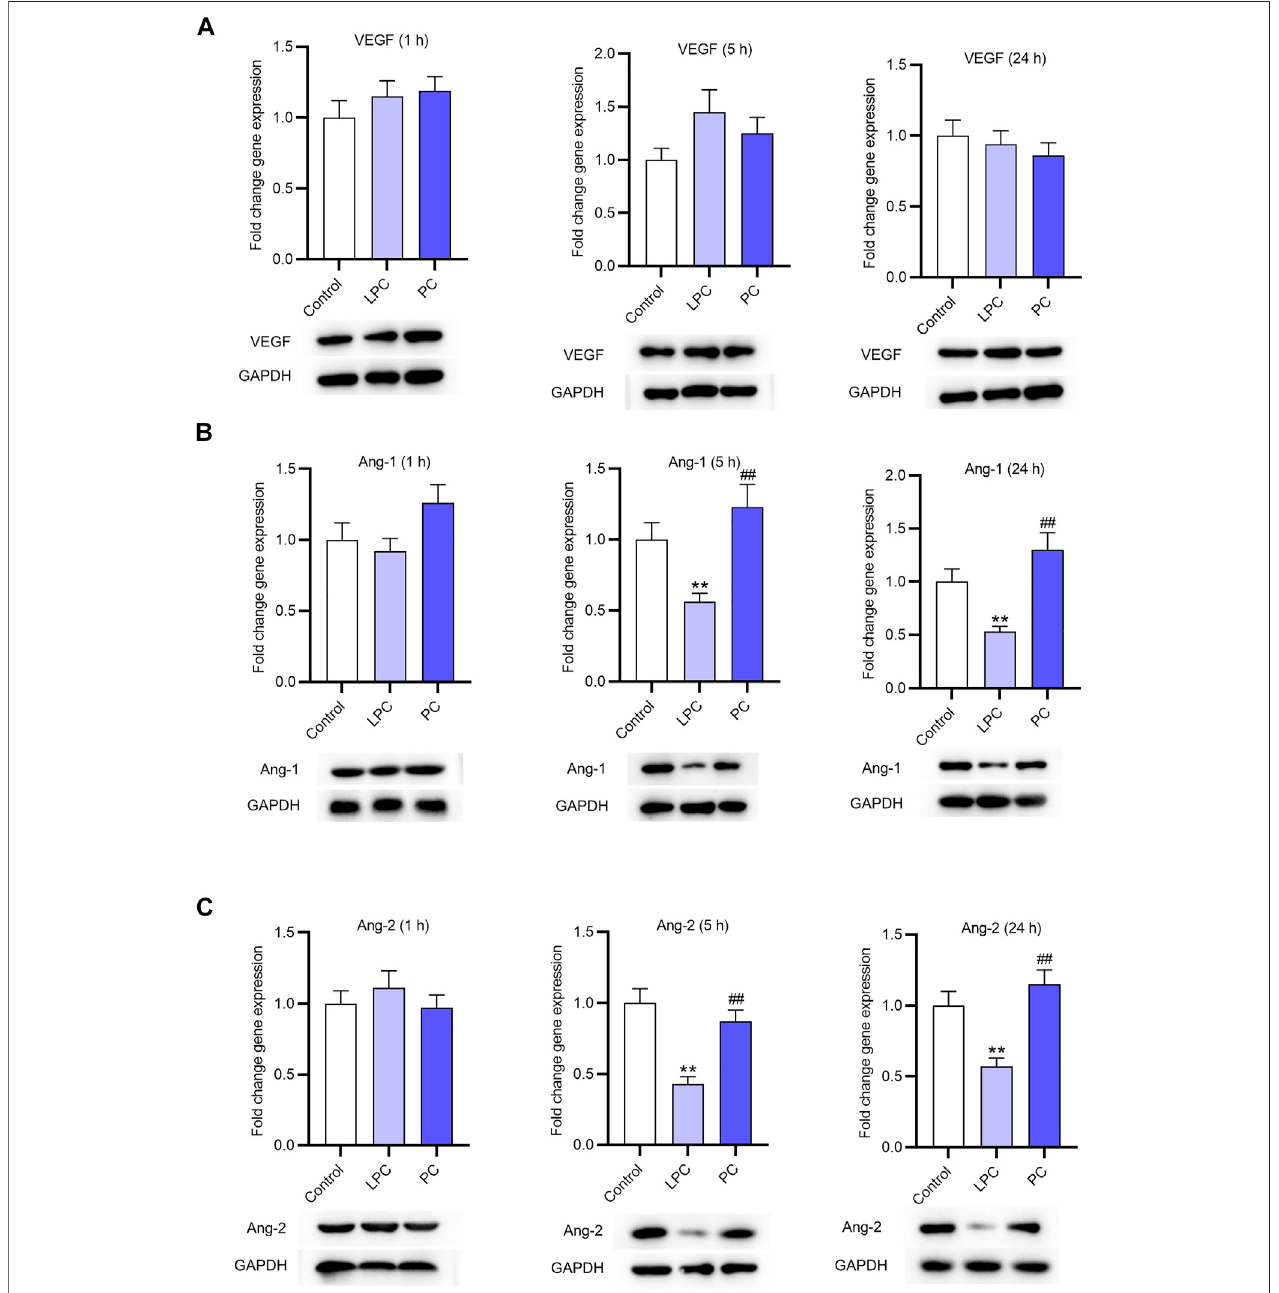
FIGURE 3 | The expression of factors associated with angiogenesis after LPC or PC treatment in EPCs. RT-qPCR and western blotting was used to access the levels ofangiogenesis-associated genesincluding VEGF (A) , Ang-1 (B) , Ang-2 (C) in EPCs after 10 μ g/ml of LPCor PC treatment for 1,5 and 24 h * p < 0.05, ** p < 0.01 compared with the control, ## p < 0.01 compared with the LPC